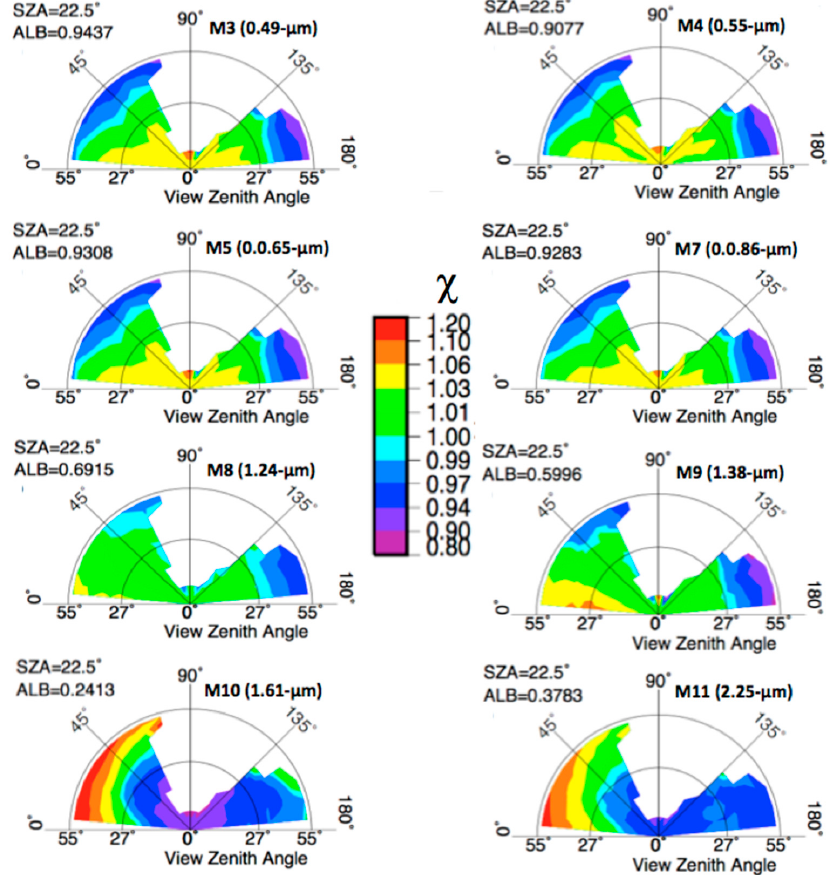
Figure 4. The annual BRDFs of the VIIRS RSB reflectances for the 5° SZA bin centered at 22.5°. The radial coordinate represents VZA (range 0° to 55°) with a 5° bin size, whereas the angular coordinate represents RAA with a 10° bin size. Direct forward scatter has an RAA of 0°, whereas a direct backscatter has an RAA of 180°. The white spaces are un-sampled bins.